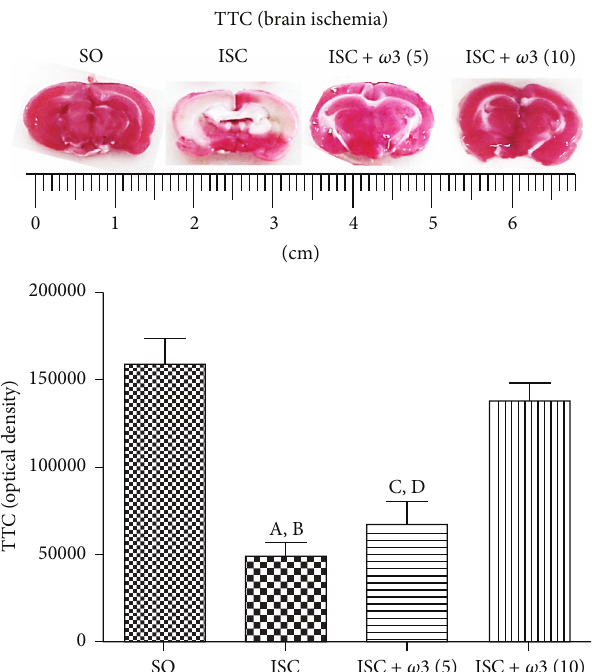
Figure 4: Effects of 𝜔 3 treatments in ischemic groups, visualized by the 2,3,5-triphenyltetrazolium chloride (TTC) staining as related to the SO group. (A) versus SO, q = 9.546 ∗∗∗ ; (B) versus ISC + 𝜔 3 (10), q = 8.194 ∗∗∗ ; (C) versus SO, q = 7.894 ∗∗∗ ; (D) versus ISC + 𝜔 3 (10), q = 6.452 ∗∗∗ (one-way ANOVA and Newman-Keuls test as the post hoc test).